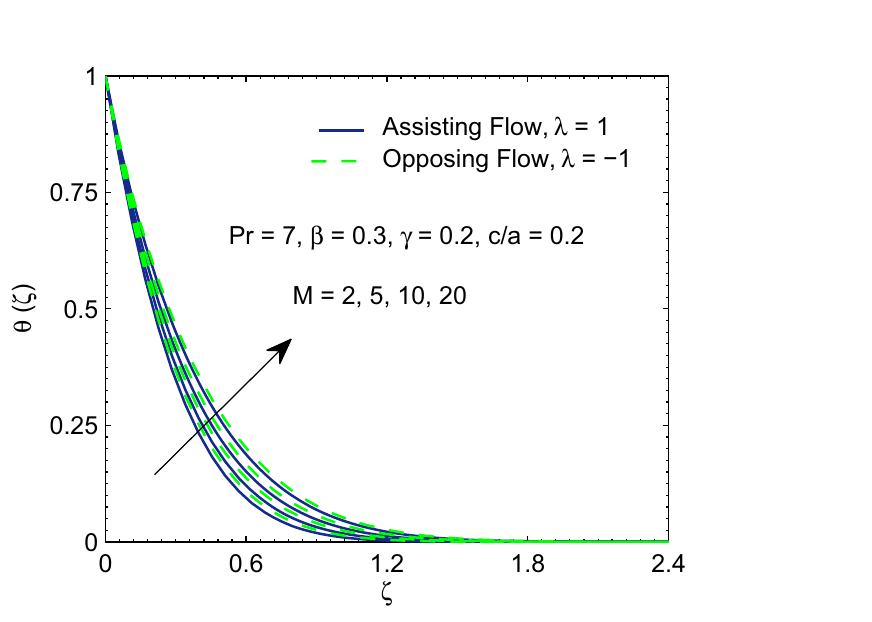
Fig 7. Profiles of θ for various values of magnetic interaction parameter M .